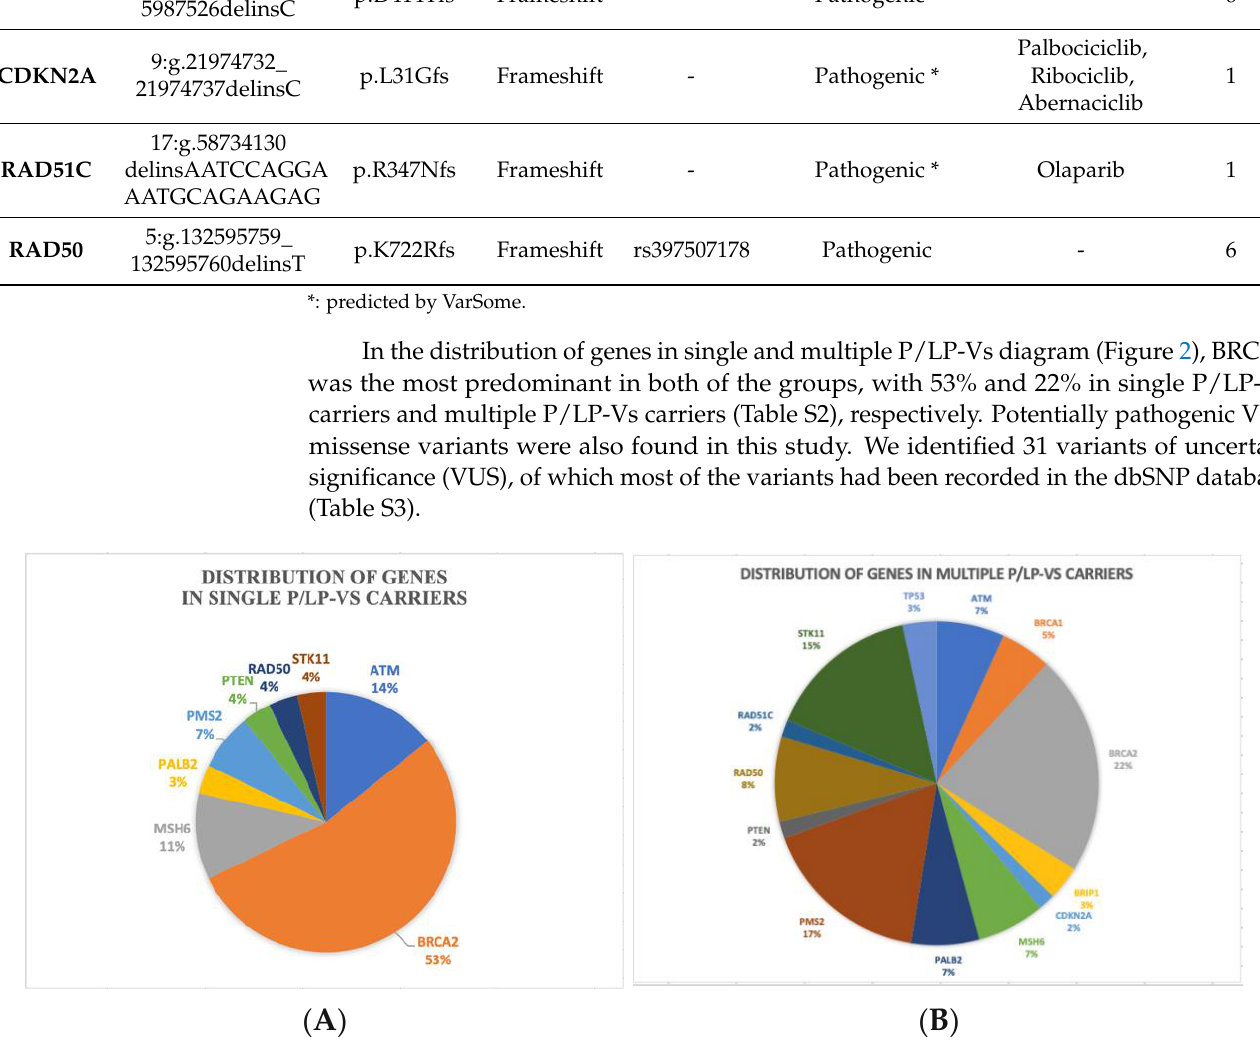
Figure 2. Distribution of genes in: ( A ) single P/LP-Vs carriers, ( B ) multiple P/LP-Vs carriers. The positions of the pathogenic variants for high-penetrance genes, such as BRCA1, BRCA2, PTEN, STK11, and TP53, were visualized in Lollipop plot, as shown in Figure 3. Most of the P/LP-Vs had not been recorded yet in the dbSNP or CinVar databases, and were designated as novel variants with their clinical significance predicted by